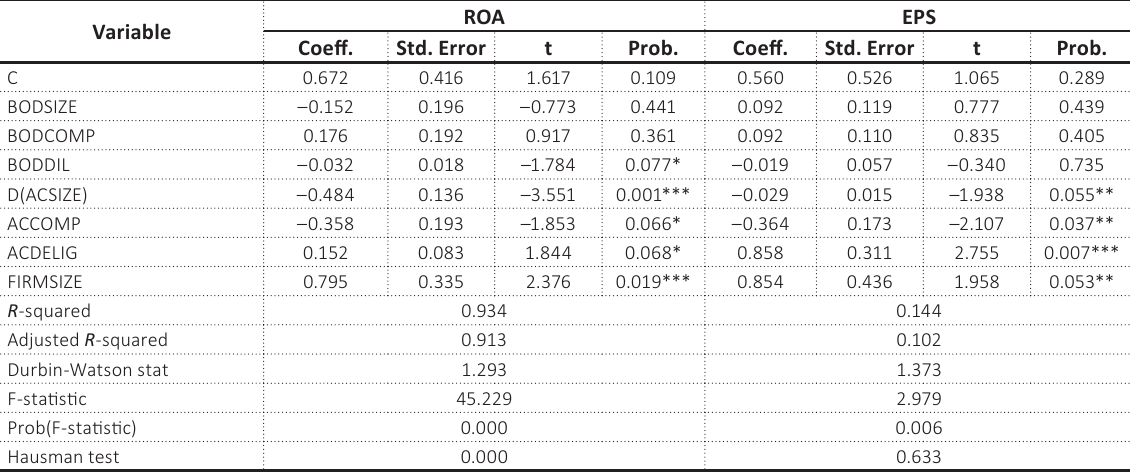
Table 4. Regression